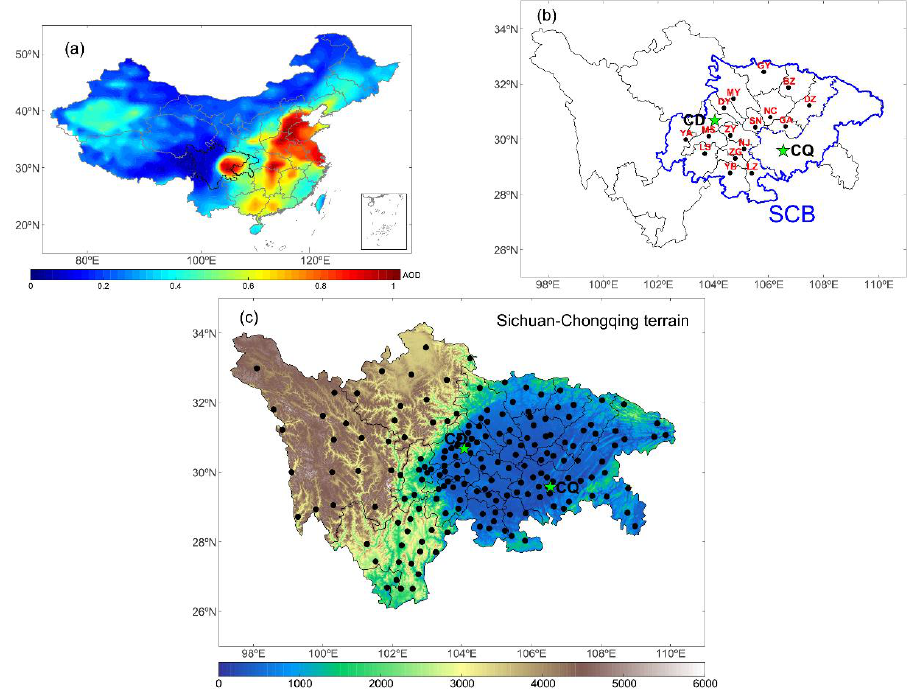
Figure 1. ( a ) Location of the Sichuan-Chongqing region (black border) and the spatial distribution of annual mean MODIS/Terra aerosol optical depth (AOD) at 550 nm for the period 2001–2016 (shading; units: non-dimensional); ( b ) Location of the Sichuan Basin (blue border) and 18 main cities; ( c ) The terrain of Sichuan-Chongqing (shading; unit: m) and the locations of 179 observation stations (black dots).